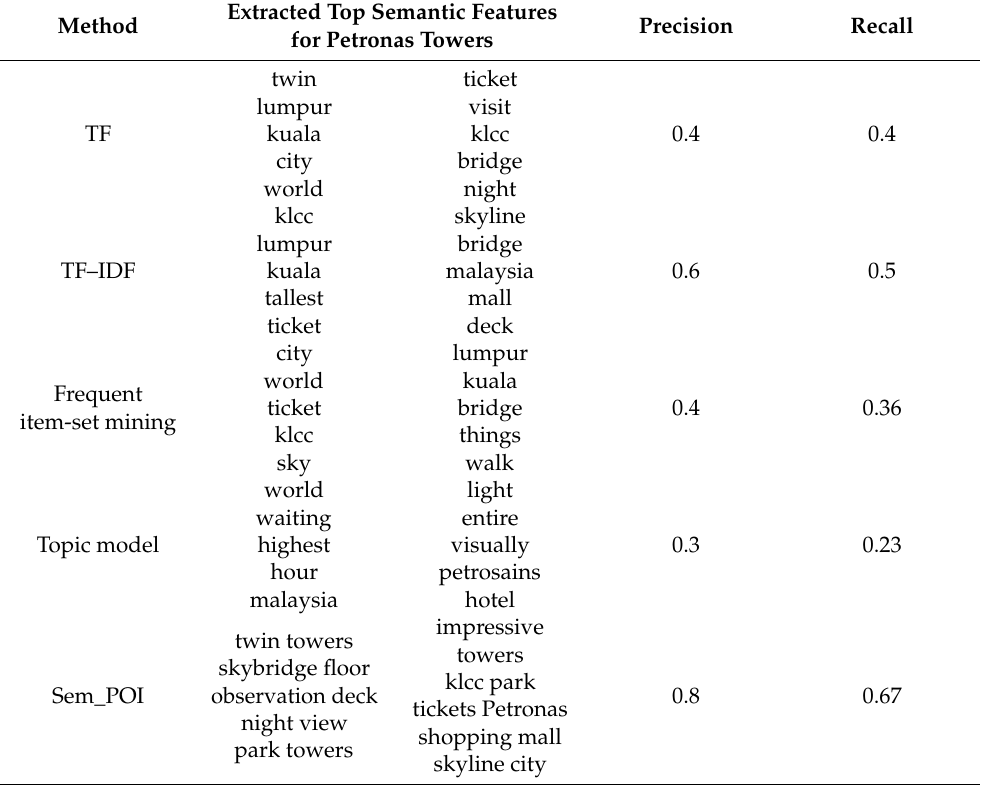
Table 9. Extracted top semantic terms of the baseline and proposed methods. Table 8. Extracted top semantic terms of the baseline and proposed methods.